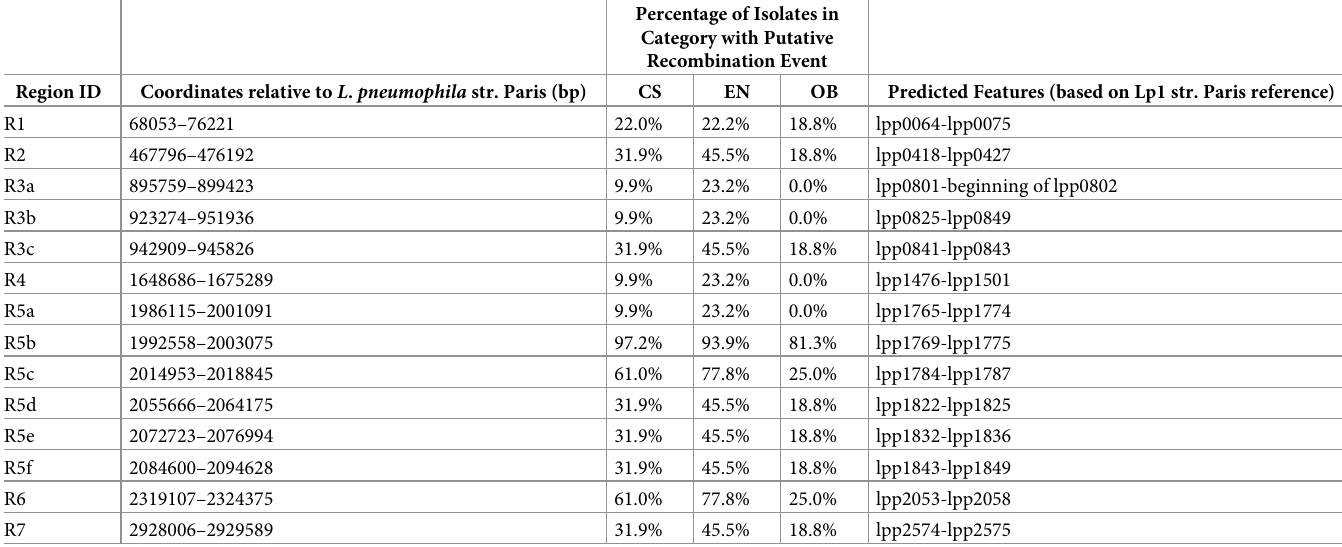
Percentage of Isolates in Category with Putative Recombination Event